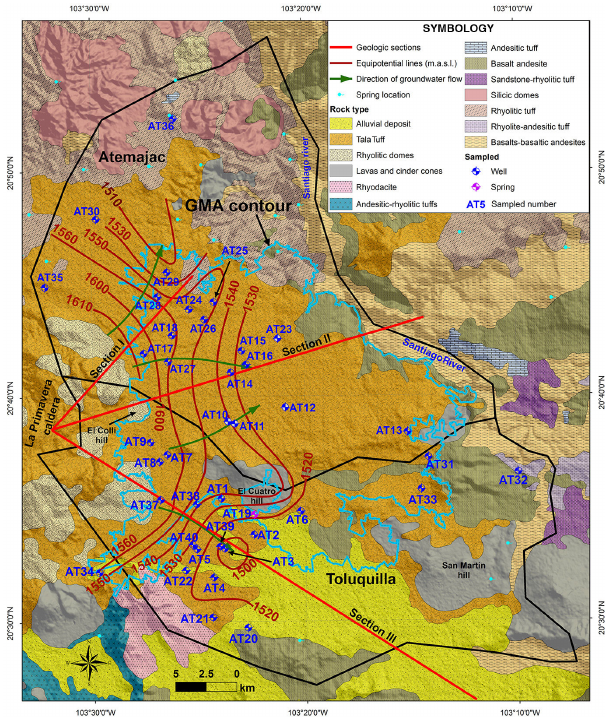
Figure 2. Surface geology, water table distribution and location of wells sampled in the study area. Note: GMA represents Guadalajara metropolitan area; the black line indicates the study